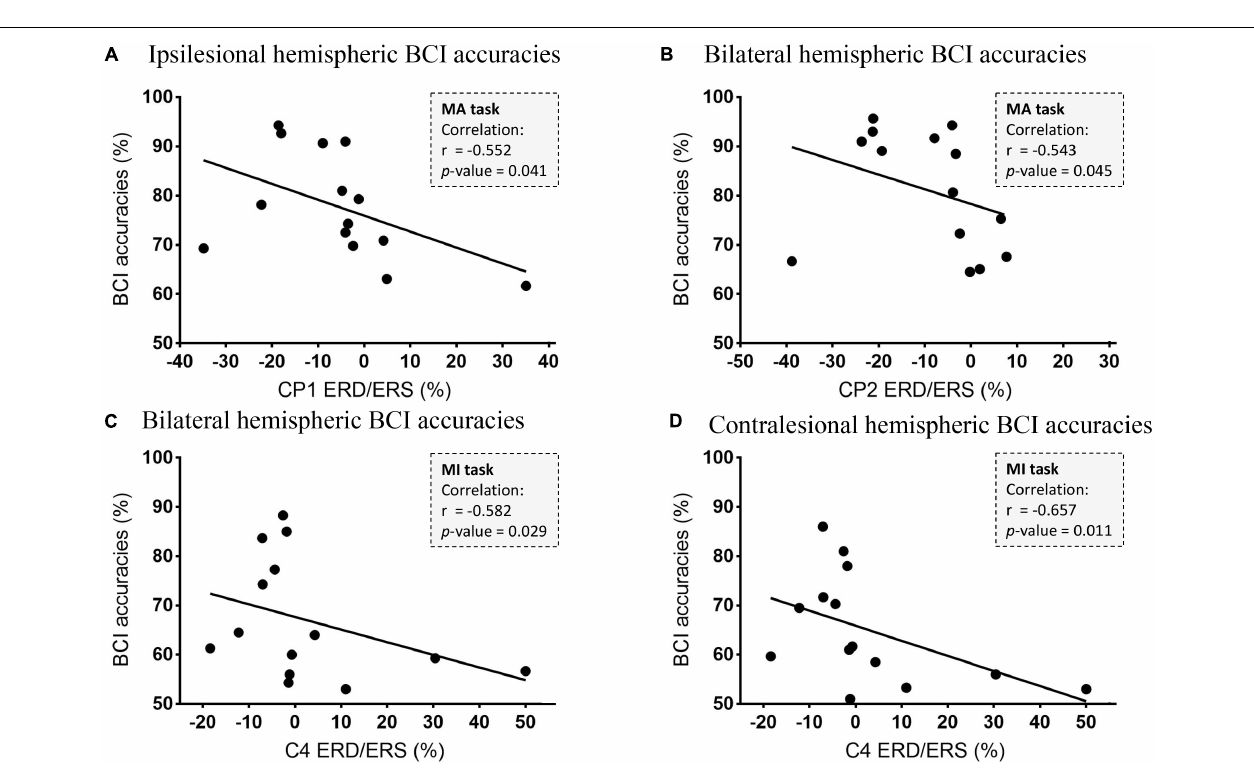
FIGURE 6 | Correlations between the BCI accuracies and ERD/ERS values in the 8–30 Hz band. (A) The correlation between CP1 ERD and the ipsilesional hemispheric BCI accuracies ( r = − 0.552, p = 0.041, n = 14). (B) The correlation between CP2 ERD and the bilateral hemispheric BCI accuracies ( r = − 0.543, p = 0.045, n = 14). (C) The correlation between C4 ERD and the bilateral hemispheric BCI accuracies ( r = − 0.582, p = 0.029, n = 14). (D) The correlation between C4 ERD and the contralesional hemispheric BCI accuracies ( r = − 0.657, p = 0.011, n =